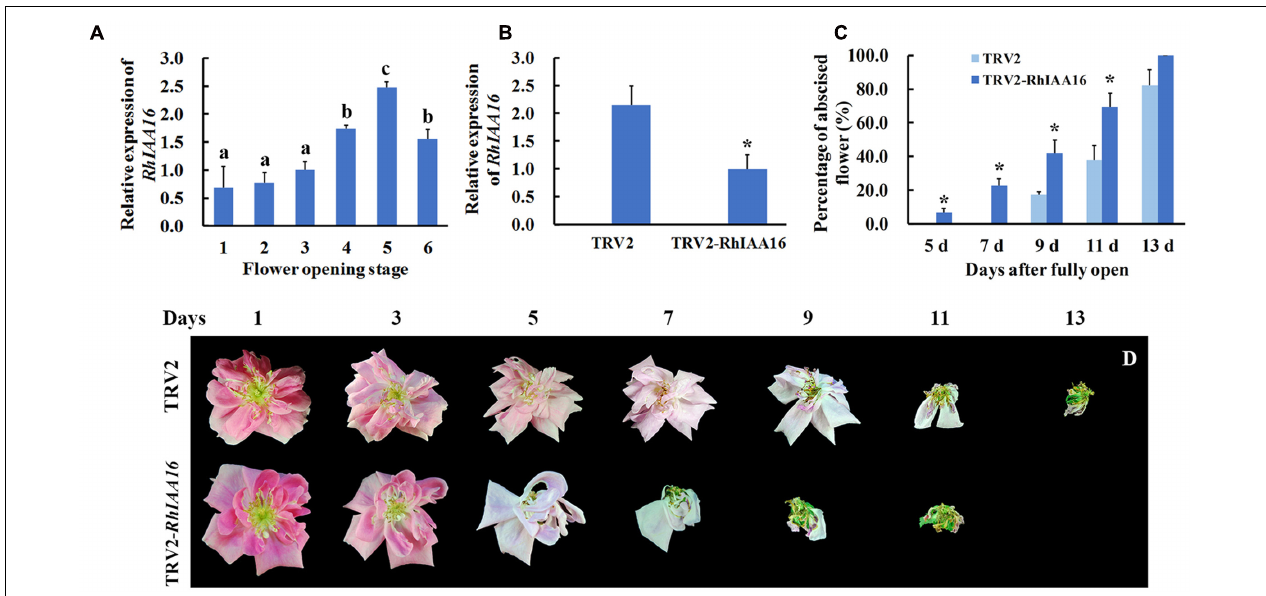
FIGURE 7 | Silencing of RhIAA16 promotes petal abscission. (A) Expression of RhIAA16 during flower opening was analyzed by qRT-PCR. (B) Expression of RhIAA16 was analyzed by qRT-PCR in RhIAA16 -silenced (TRV2-RhIAA16) and control (TRV2) plants. (C) The percentage of abscised flowers were determined at intervals after fully open in RhIAA16 -silenced (TRV2-RhIAA16) and control (TRV2) plants. Abscised flower was defined as the flower with all the petals shed. (D) The phenotypes of flowers were recorded and photographed every 2 days. The results were the means of three biological replicates with standard deviation. Letters indicated significant differences according to Duncan’s multiple range test ( P < 0.05), and asterisks indicated statistically significant differences (Student’s t -test, P <